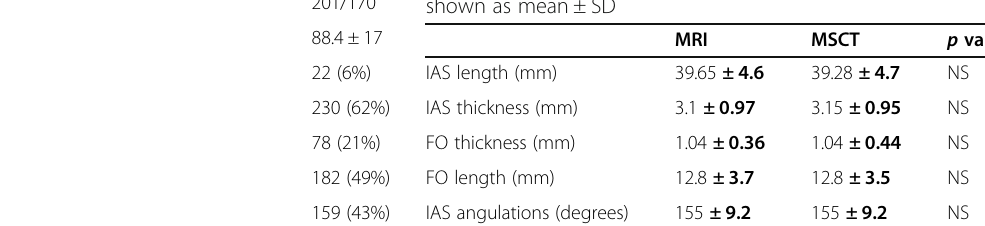
Table 3 Measurements of various interatrial septum characteristics by 3-T MRI and MSCT. All measurements